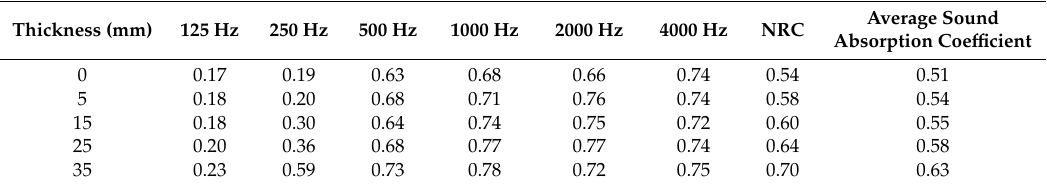
Table 5. Noise reduction coe ffi cient (NRC) and average sound absorption coe ffi cient for varied air gap thickness.